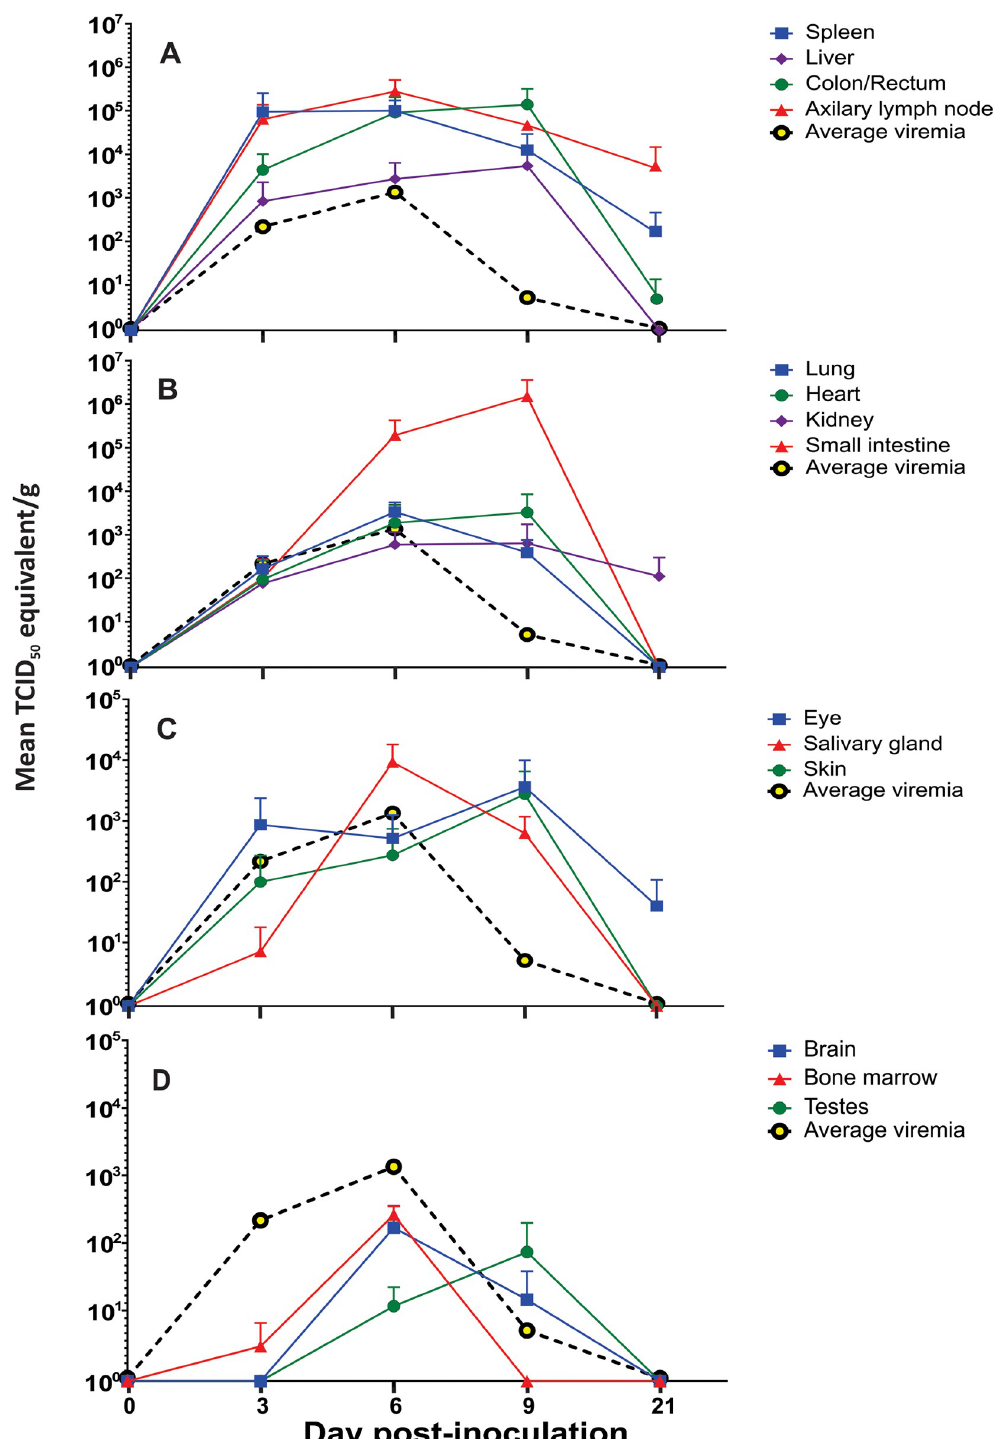
Fig 3. Sosuga virus RNA detected in tissues of inoculated bats. Mean Sosuga virus RNA levels (TCID 50 /g equivalent) in groups of three bats euthanized at 3, 6, 9- and 21-days post inoculation in (A) spleen, liver, colon/rectum, and axillary lymph node, (B) lung, heart, kidney, and small intestine, (C) eye, salivary gland, and skin at inoculation site and (D) testes, bone marrow and brain. Each symbol (point) represents the mean viral load detected in the corresponding tissue collected from the 3 bats euthanized on that day. For reference, the mean viral loads detected in blood from the same bats euthanized on that day are shown as a dashed black line with yellow dots.